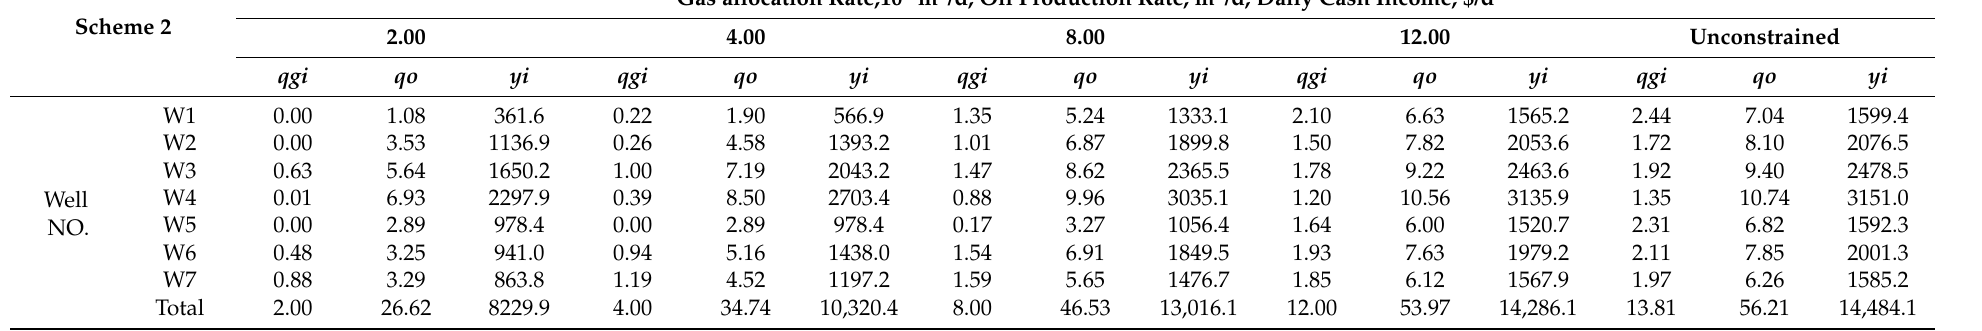
Table 9. Gas allocation result of various injected gas rate of Scheme